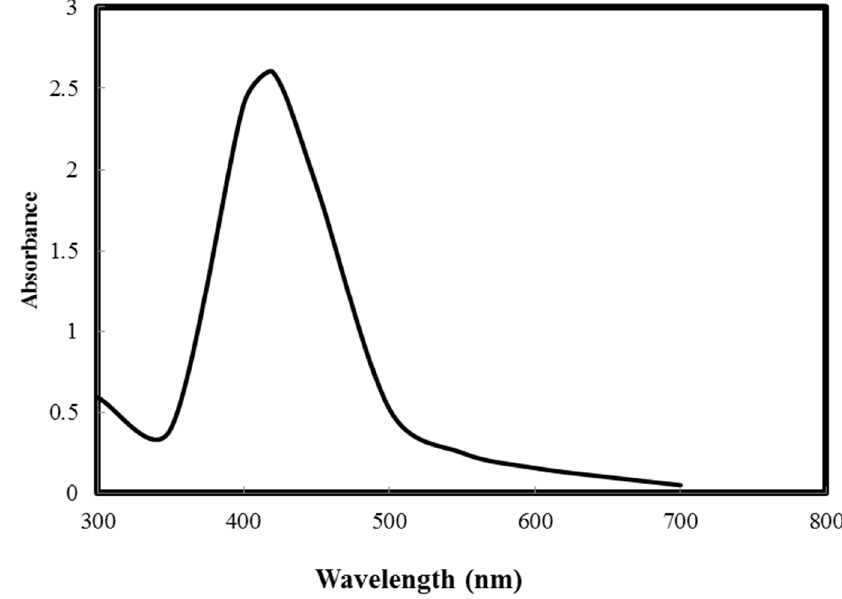
Figure 5. UV–visible absorption spectra of AgNPs.